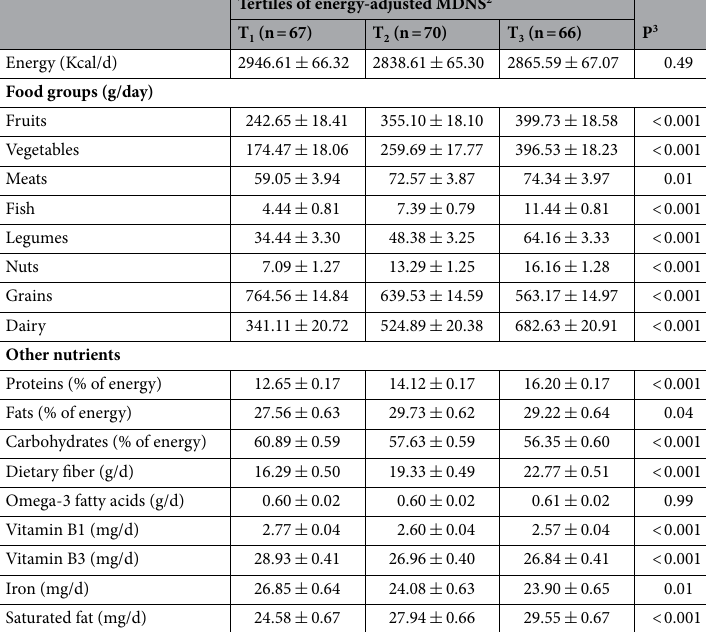
Table 2. Multivariable-adjusted intakes of selected food groups and nutrients of study participants across tertiles of methyl donor nutrients score (n = 203) 1 . 1 All values are means ± standard error (SE); energy and macronutrients intake is adjusted for age and gender; all other values are adjusted for age, gender and energy intake. 2 MDNS components were adjusted for energy intake based on residual method. 3 Obtained from ANCOVA.